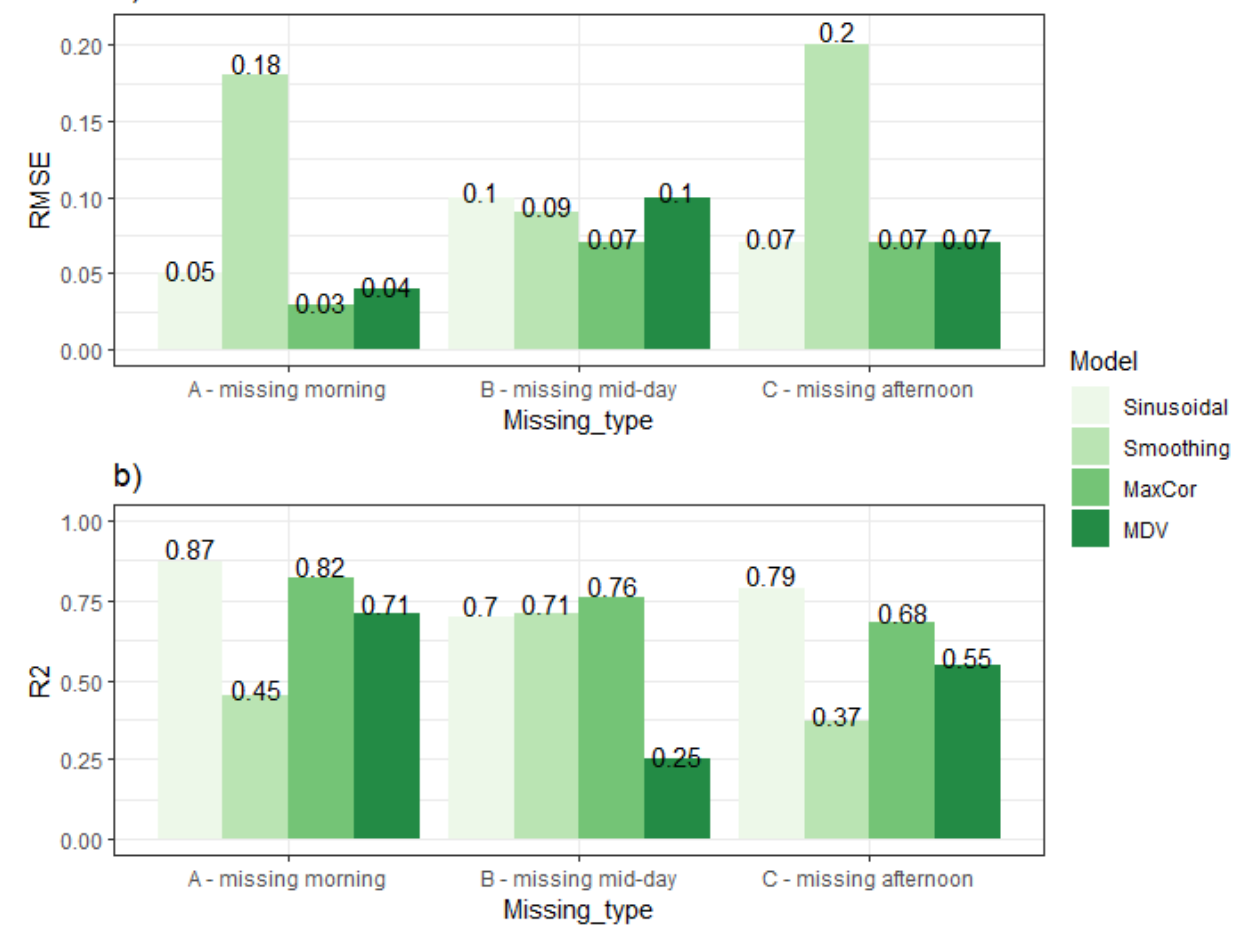
Figure 6. ( a ) RMSE and ( b ) R 2 of the 30-min ET a (in mm) for the infilled gaps, obtained from the four infilling models for each evaluation dataset that represents typical patterns of missing data: A—missing morning; B—missing mid-day; and C—missing